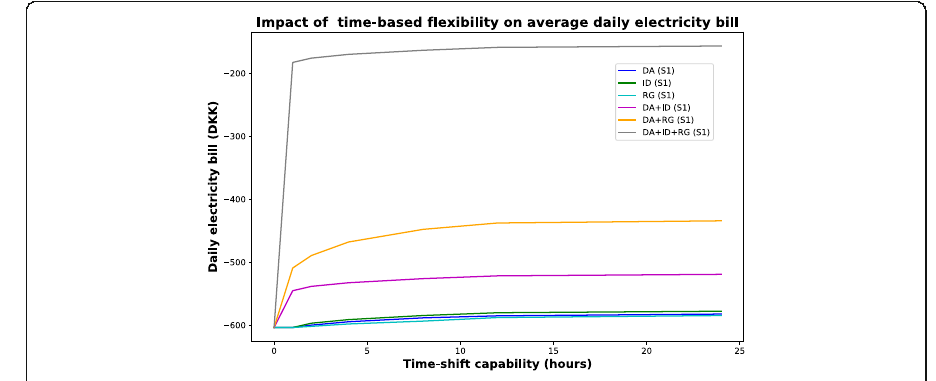
Fig. 6 Daily electricity bill depending on time-shift capacity (scenario